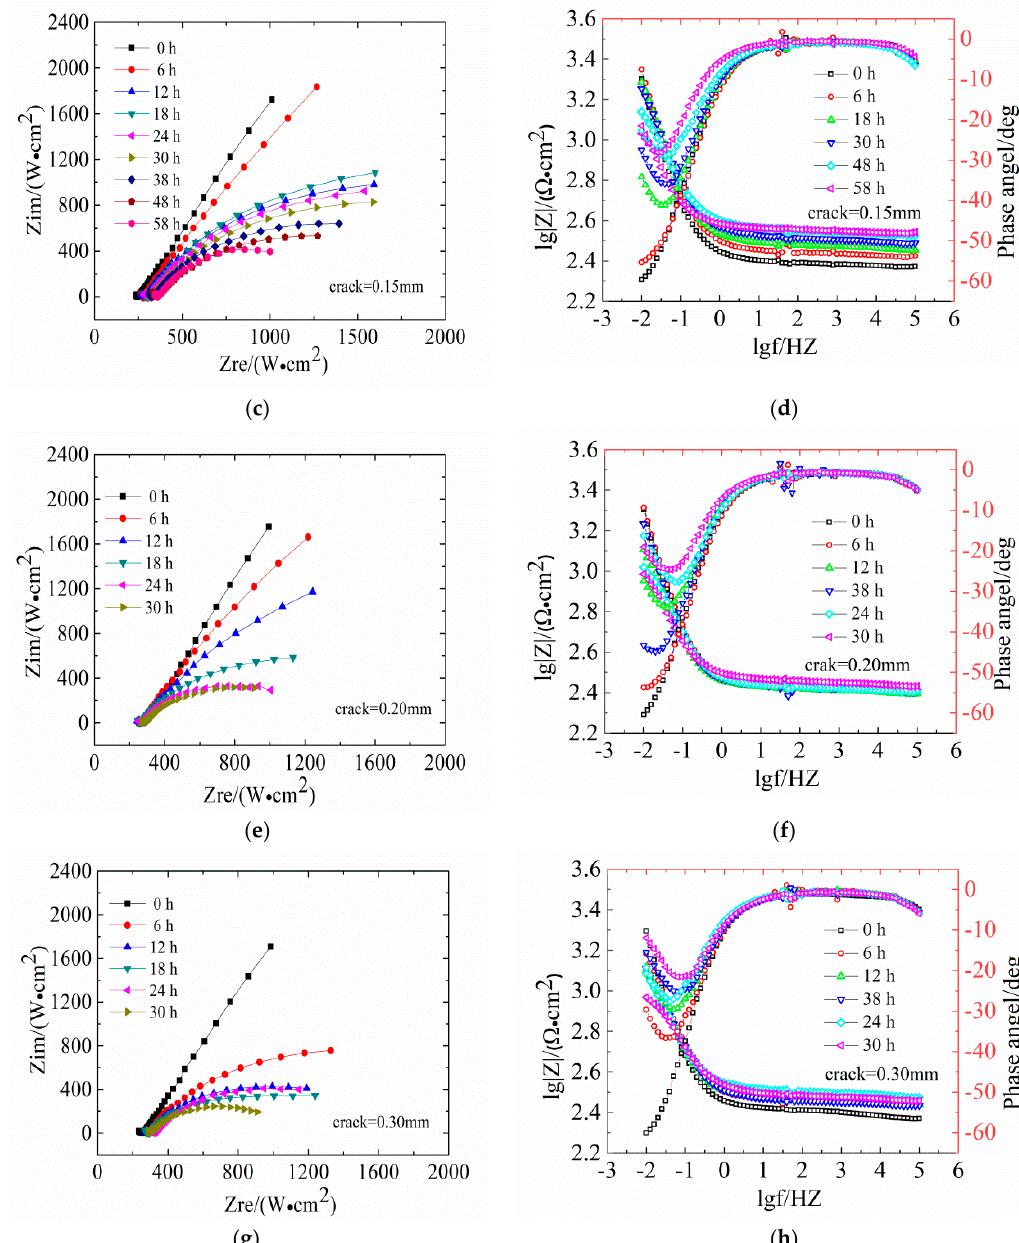
Figure 9. Evolutions of Nyquist plots for reinforced corrosion resistant concrete with different transverse crack widths. ( a , b ) Crack width = 0.10 mm; ( c , d ) Crack width = 0.15 mm; ( e , f ) Crack width = 0.20 mm; ( g , h ) Crack width = 0.30 mm.